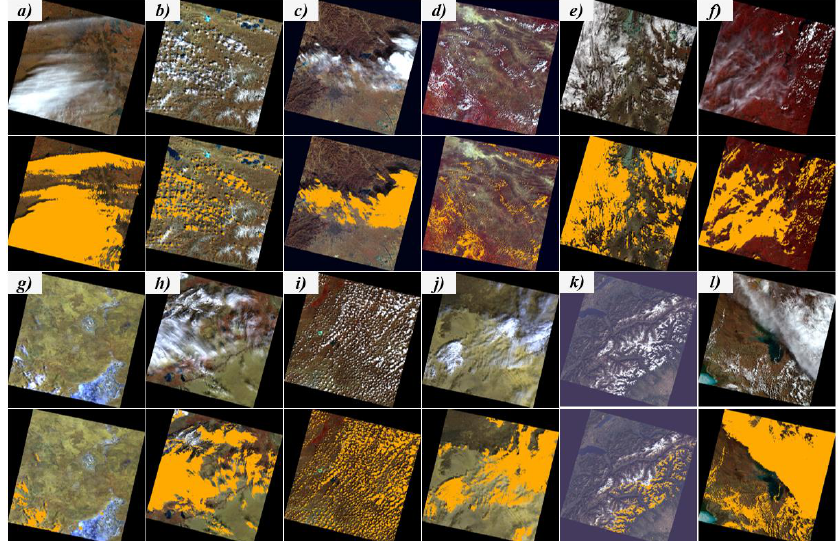
Figure 4. Cloud masks generated by the CECD for twelve Landsat-8 test scenes. ( a – l ) are the corresponding Landsat-8 scenes from sites a to l (Table 1). The upper row is the color-composited cloudy images. The lower row is the corresponding CECD cloud masks (in orange).